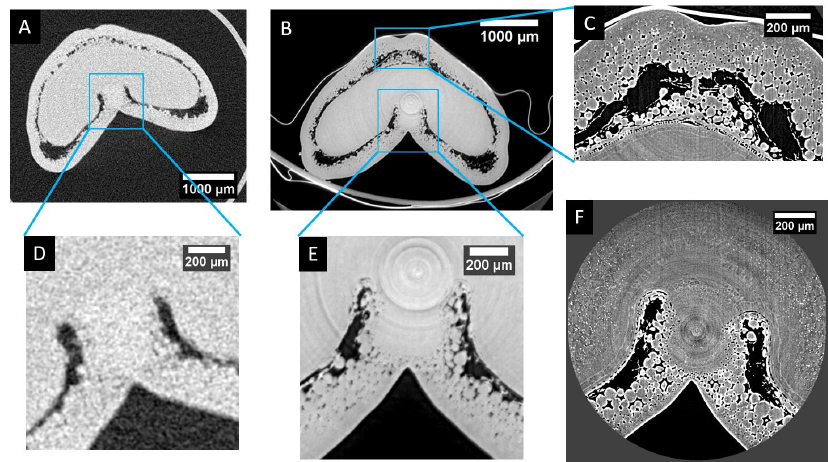
Figure 7. Visual comparison of the resolution obtained with three different X-ray micro-tomography setups. ( A ) Laboratory microtomography of the whole grain (using the same settings as in [7]). ( B ) “Low-resolution” synchrotron phase-reconstruction tomography (2.86 µ m/voxel). ( C ) “High-resolution” synchrotron phase-reconstruction tomography of the dorsal region (0.64 µ m/voxel). ( D , E ) Zoom of the highlighted region of ( A ) and ( B ), respectively. ( F ) “High-resolution” synchrotron phase-reconstruction tomography of the ventral region (0.64 µ m/voxels).